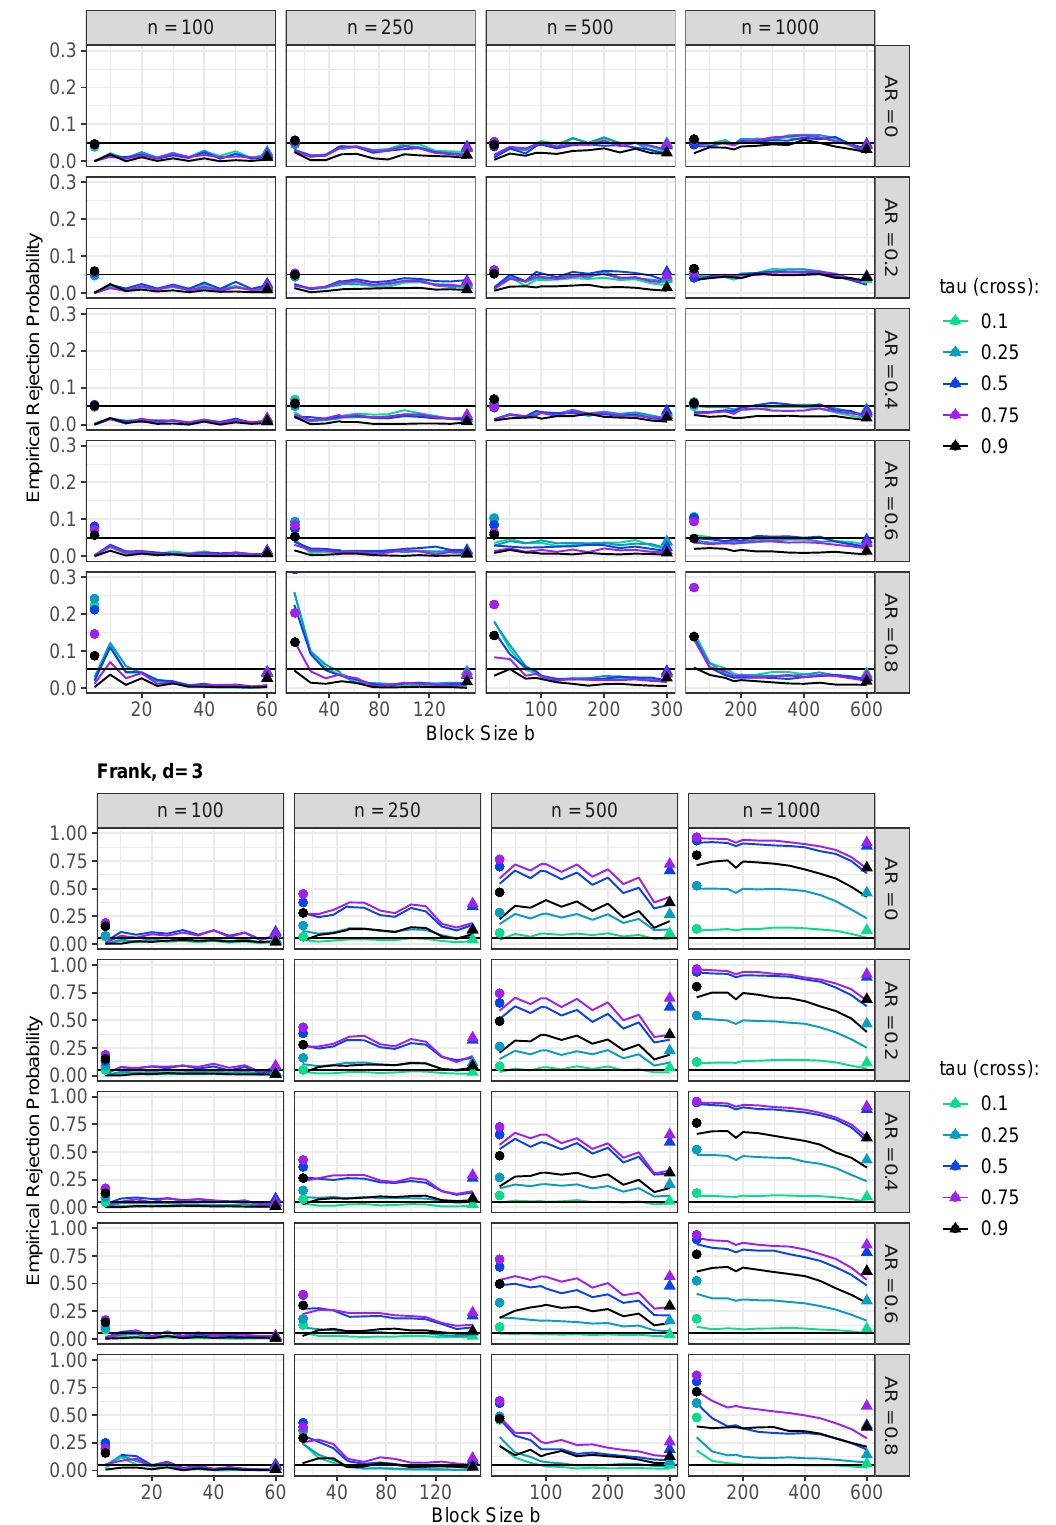
Figure 2: Empirical rejection probabilities for the Gaussian model (upper part) and Frank model (lower part) in dimension d =3 against the block size b for n ∈ { 100, 250, 500, 1000 } . AR = c refers to the fact that the marginal AR models were chosen in such a way that the lag 1 auto-Kendall-rankcorrelation equals c ∈ { 0, .2, .4, .6, .8 } . Likewise, τ (cross) ∈ { 0.1, 0.25, 0.5, 0.75, 0.9 } specifies the (pairwise) cross sectional dependencies in terms of Kendall’s tau. Empirical rejection probabilities for the test from [37] and for our test with fixed block size b = (cid:98) n 0.95 /4 (cid:99) are depicted as points on the left side and triangles on the right side,